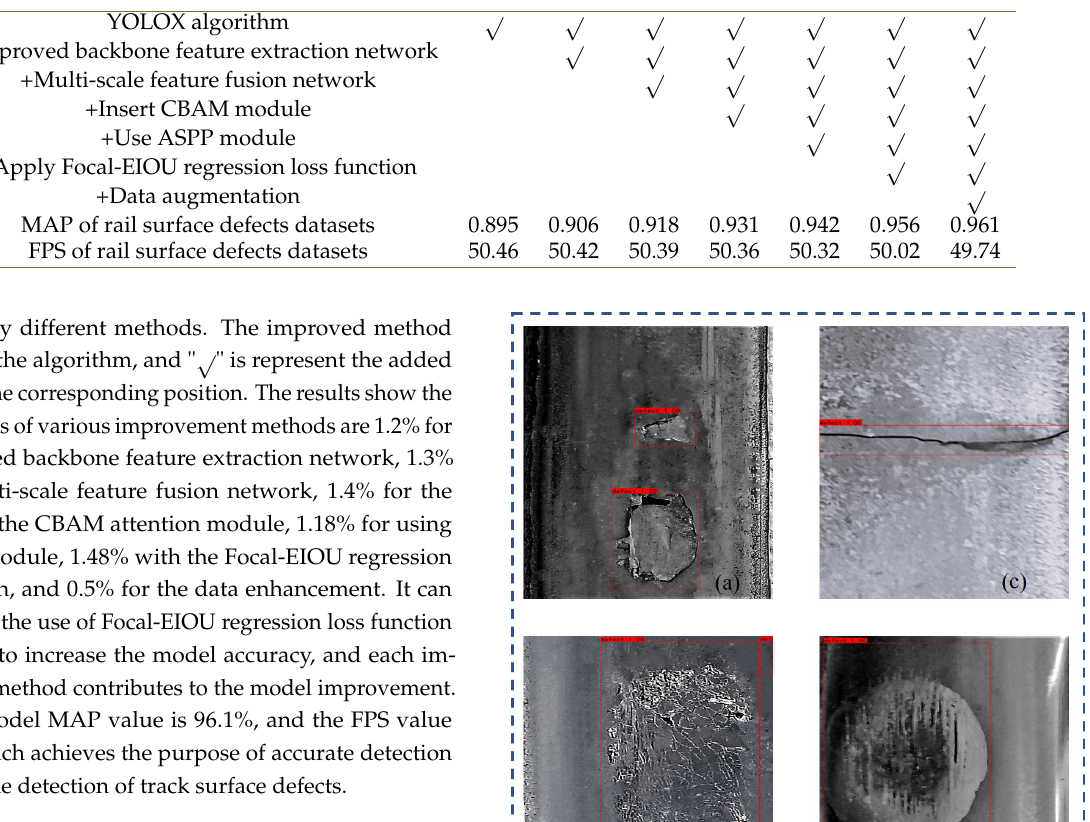
Table 6. Ablation experiments with different improved methods.